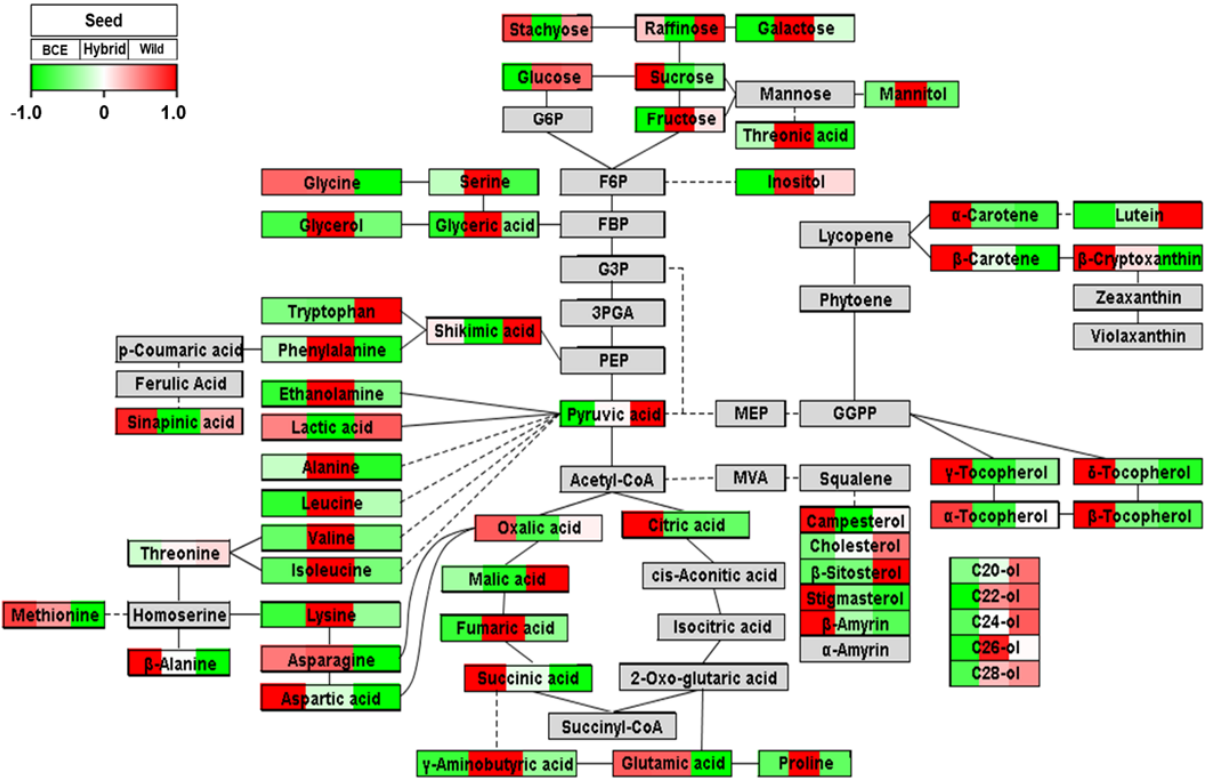
Figure 3. Metabolic pathways visualization of BCE, Hybrid, and Wild seeds. The UV scaling value range is from − 1.0 to 1.0. A UV scaling value >0 indicates higher levels than average in each value of BCE, Hybrid, and Wild (shown in red). A UV scaling value <0 indicates lower than average values and is shown in green. Gray color represents an undetected compound.